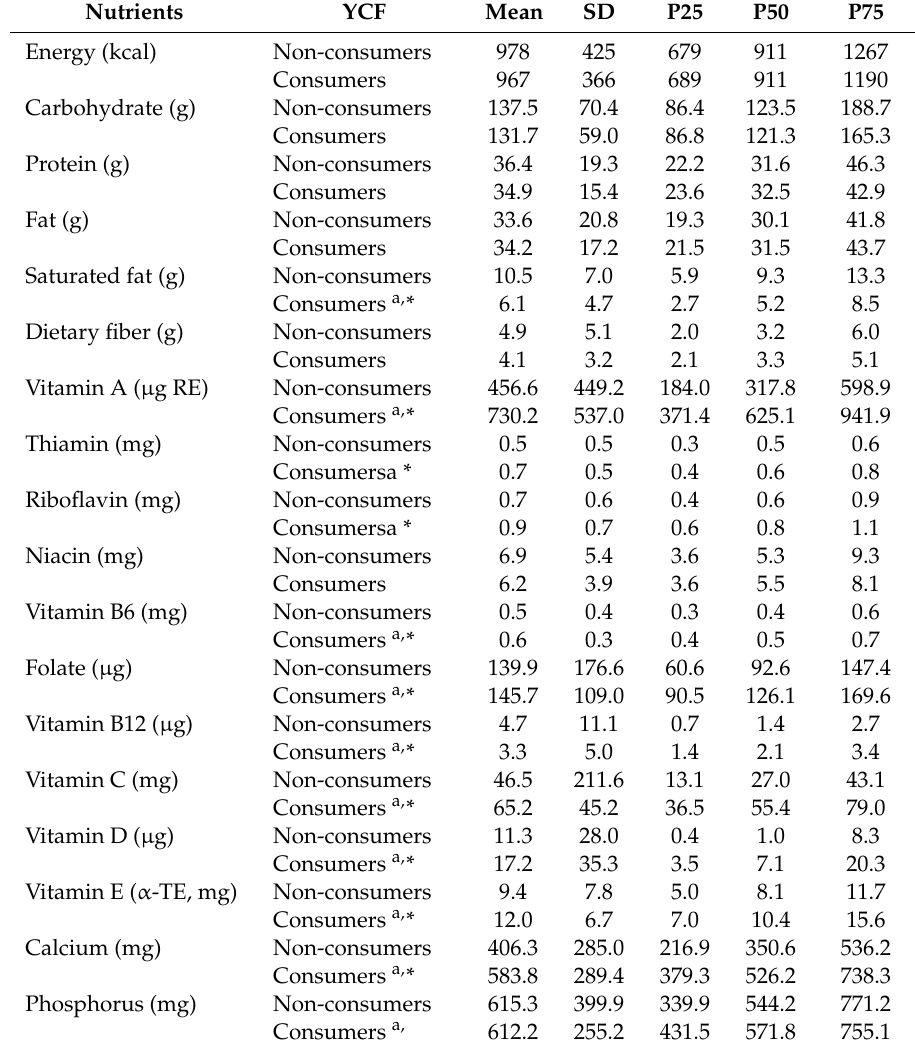
Table 2. Comparing the daily energy and nutrient intakes between young children formula (YCF) consumers and non-consumers in children aged 12 to 36 months (total N =